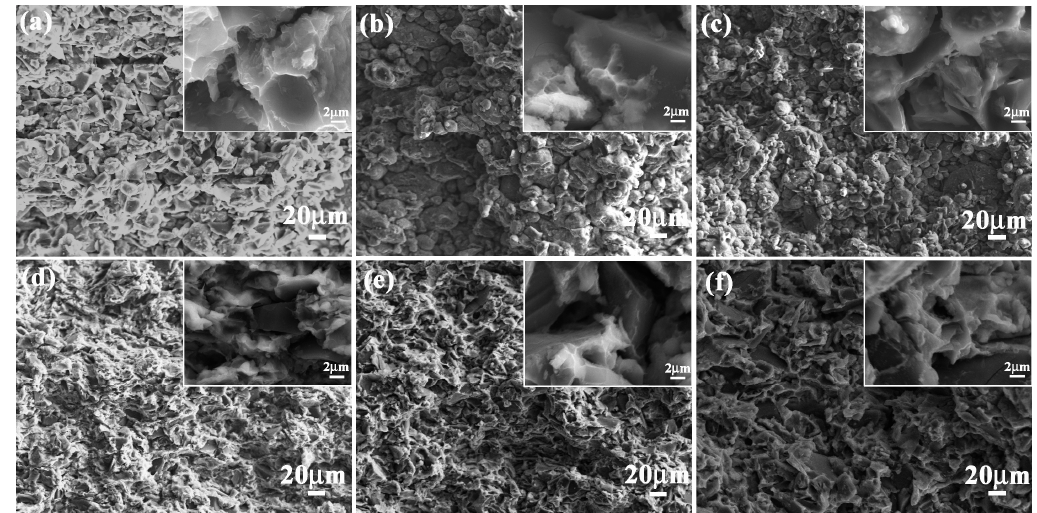
Figure 8. Fracture appearance of ( a ) Outer layer; ( b ) Middle layer and ( c ) Inner layer of bionic Meretrix lusoria shell composite material and ( d ) Outer layer; ( e ) Middle layer and ( f ) Inner layer of bionic Rapana venosa shell composite